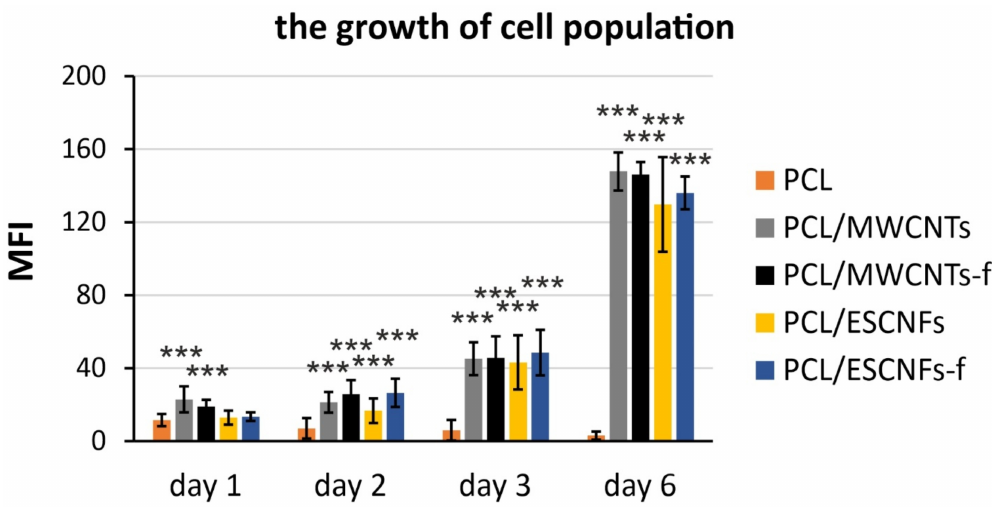
Figure 4. The growth of U-2 OS-Green cells on PCL; PCL/MWCNTs, PCL/MWCNTs-f, PCL/ESCNFs and PCL/ESCNFs-f; nanomaterials, monitored at the 1st, 2nd, 3rd (40 ms exposure, gain = 1) and 6th day post-seeding (15 ms exposure, gain = 1). The bar represents the means ± SD of the mean fluorescence intensities (MFI) from 9–20 separate images (median images number = 12.5). For the MFI quantifications background subtraction was applied. Statistical analysis was performed with one-way ANOVA with the Tukey post-hoc test: ***, p < 0.001 versus PCL. The differences in exposure time were compensated in the